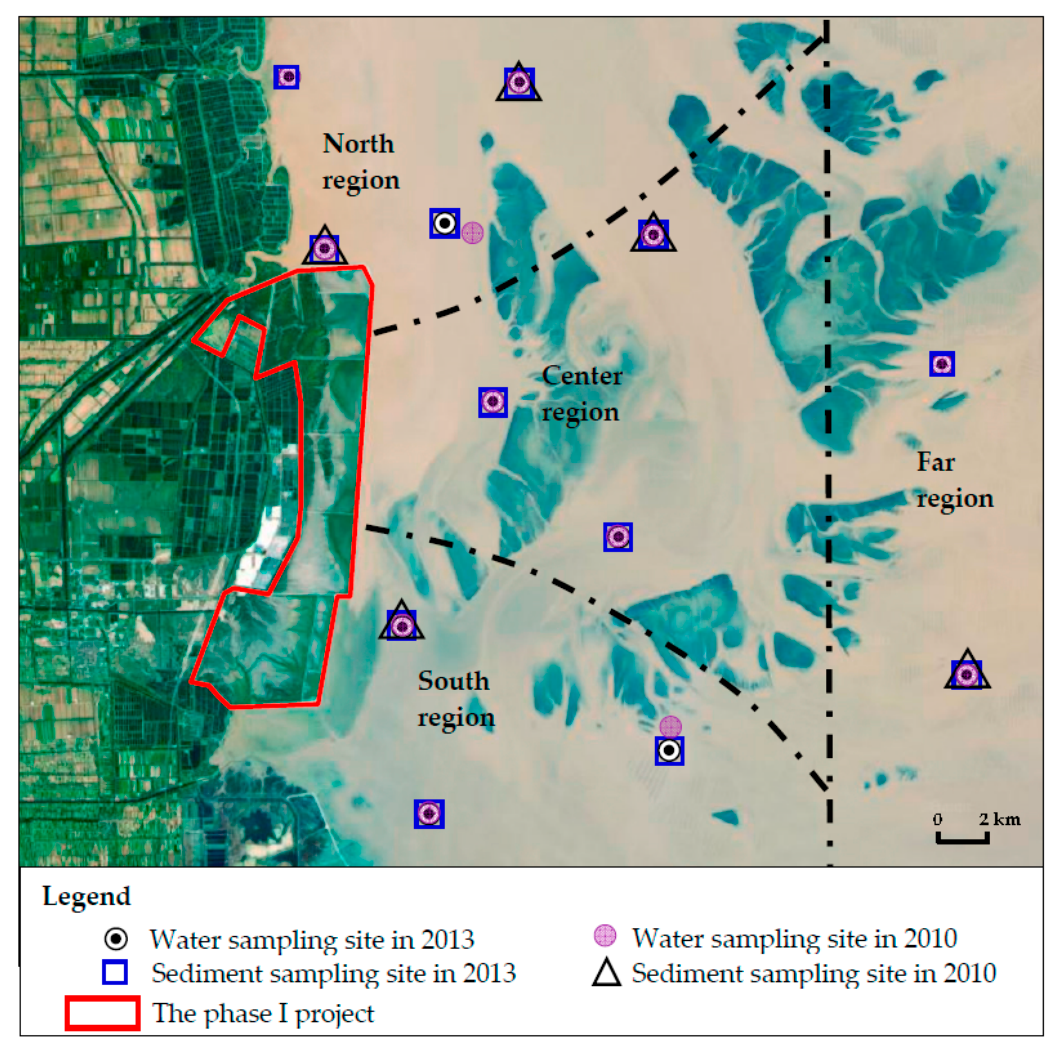
Figure 4. Location of the sampling sites. Table 1. Descriptive statistics of measured variables of water and sediment samples pre-Phase I (April 2010).